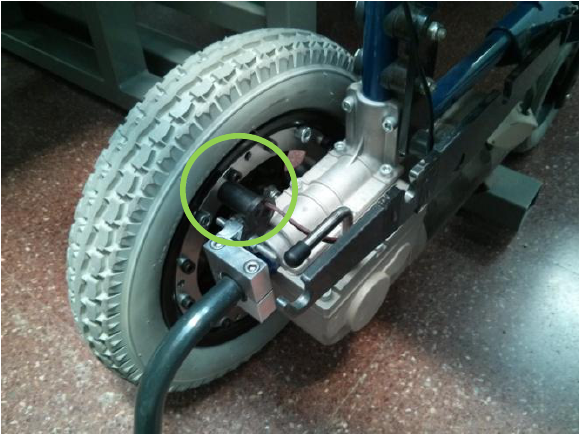
Figure 7. Incremental encoder based on Hall effect sensor to implement odometry.